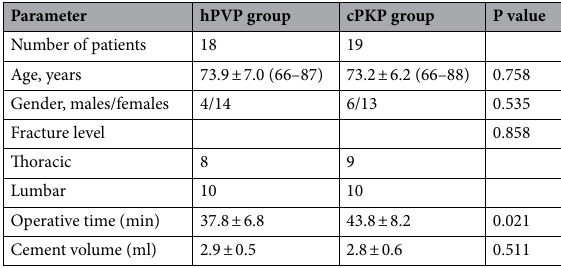
Table 1. Characteristics of the patient cohort in both groups.